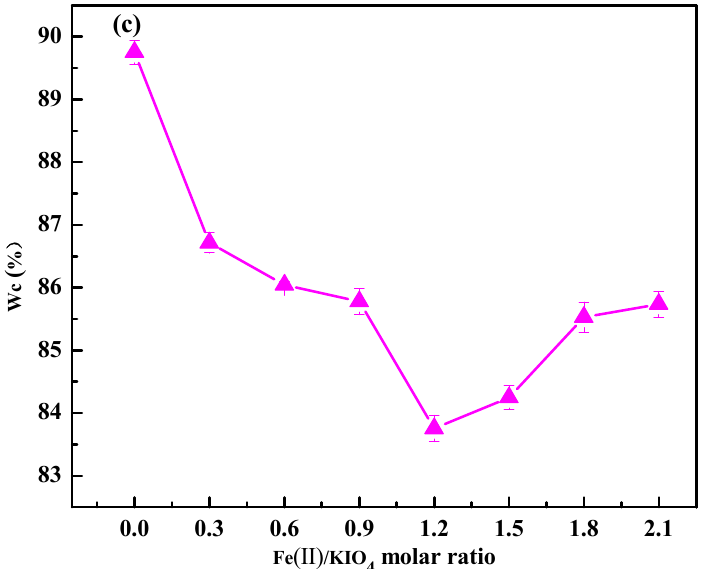
Figure 3. Effect of Fe(II)/KIO 4 molar ratio on performance indices of sludge dewatering. ( a ) CST, ( b ) SRF, and ( c ) W C . Conditions: Initial pH = 6.8; KIO 4 dose = 1.4 mmol/g VSS.